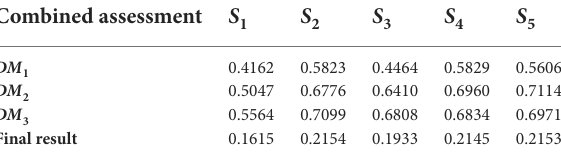
TABLE 14 Comparison of the ranking of alternatives with different approaches. Approach Ranking FDEMATEL and